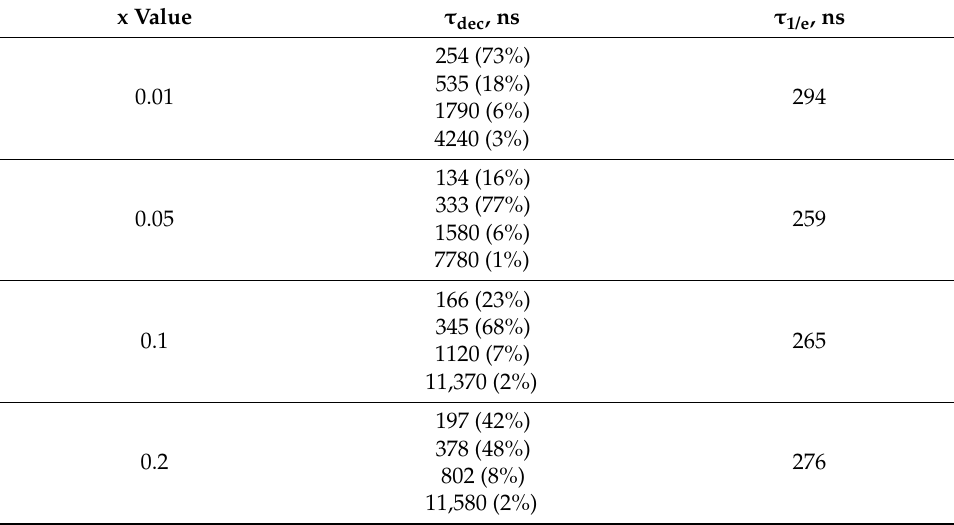
Figure 7. Decay curves of the UV-C (E em = 5.2 eV for x = 0.01, 0.1, 0.5; 5.45 eV for x = 0.8 and 5.95 eV for x = 1) emission band of Y 1 − x Sc x PO 4 at 300 K under pulsed electron beam excitation. Table 4. Decay components τ dec and their weight (%) as well as τ 1/e at T = 290 K.